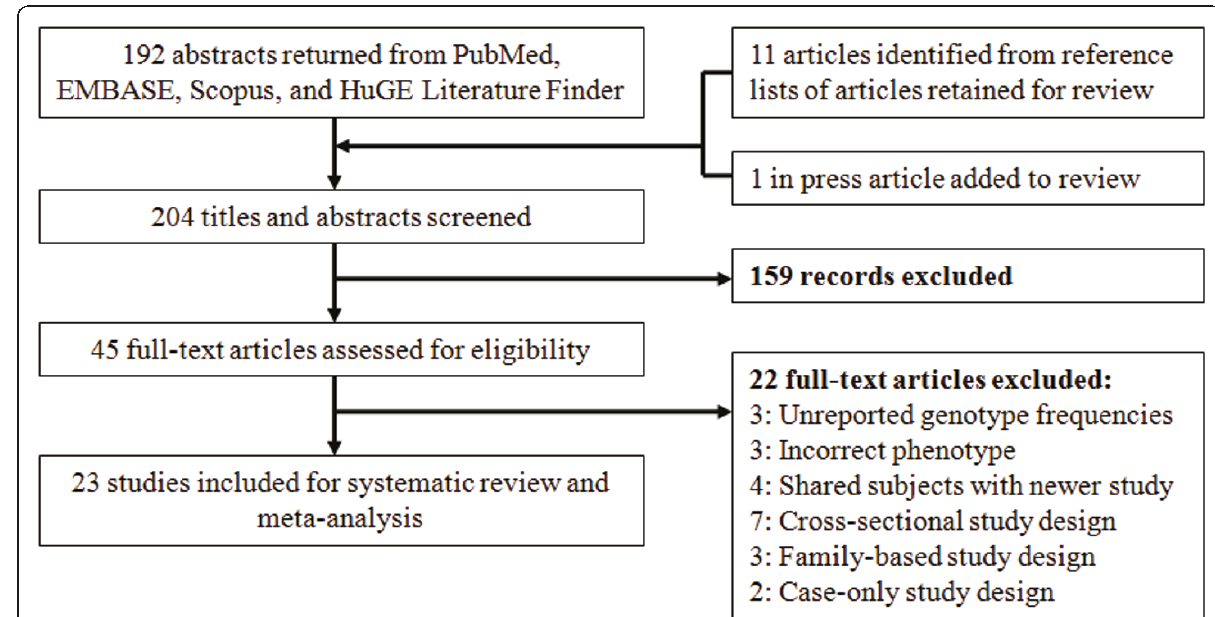
Figure 1 Flow diagram of the systematic review and meta-analysis literature search results . HuGE is the Human Genome Epidemiology